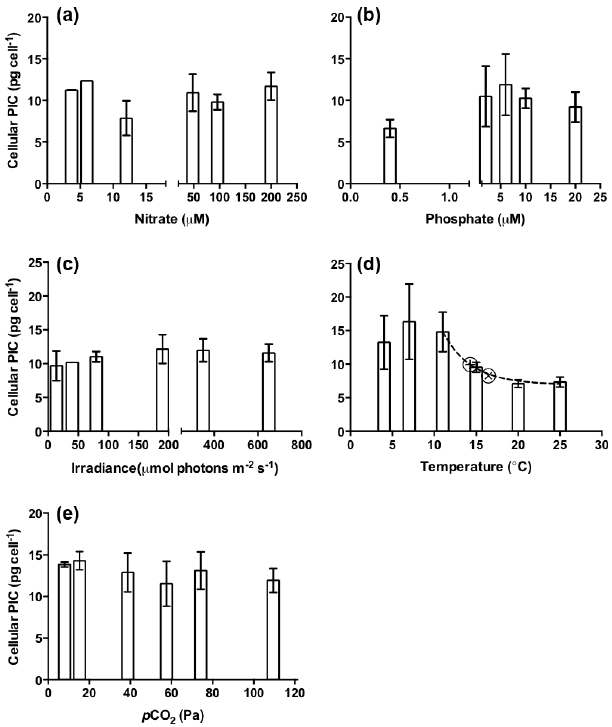
Figure 1. Changes in Emiliania huxleyi cellular particulate or- ganic carbon (POC) content in response to different environmen- tal drivers: (a) cellular POC vs. nitrate concentration; (b) cellular POC vs. phosphate concentration; (c) cellular POC vs. irradiance; (d) cellular POC vs. temperature; and (e) cellular POC vs. p CO 2 . For Figs. 1–5, the dashed lines represent the fitted dose–response curves. “ ⊕ ” represents the fitted values for the present-day condi- tions in the Chatham Rise area, and “ ⊗ ” represents the fitted values for the predicted future conditions (2100) in the Chatham Rise area. Error bars represent standard deviations ( n = 3).